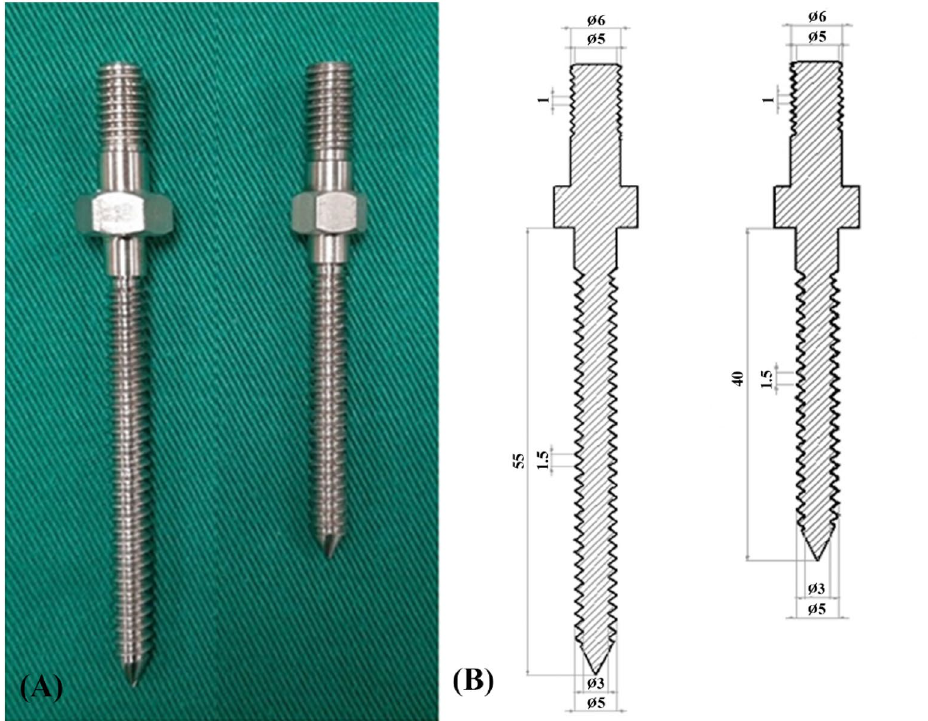
Figure 9. ( A ) Photograph and ( B ) schematic drawing showing the pedicle screws with different lengths. Screws with a dimension (diameter × length) of 5.0 mm × 55 mm were used in the bicortical fixation modality (( B ), left side) and that of 5.0 mm × 40 mm were used in the unicortical fixation modality (( B ), right side).